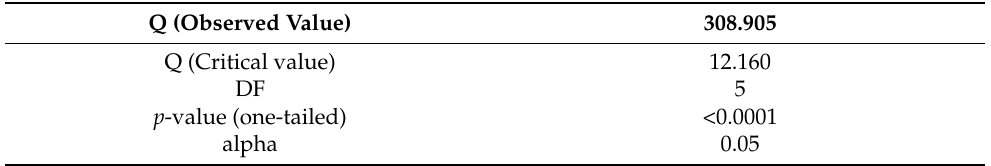
Table 6. Friedman test for the most performed activities.